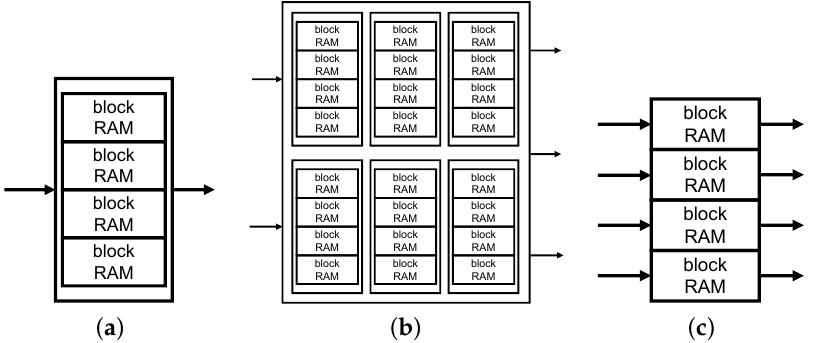
Figure 6. Block RAM usage patterns of different hash tables. ( a ) Normal combination (1 writing port and 1 reading port), ( b ) LVT-based hash table (2 writing ports and 3 reading ports), ( c ) HybriDC hash table (4 writing ports and 4 reading